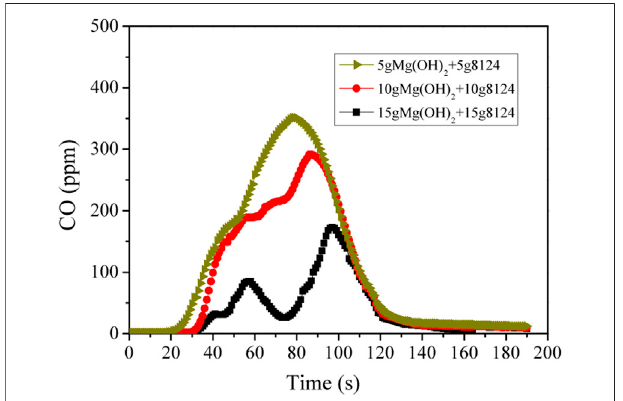
FIGURE 10 | CO concentration of compound foam with Mg(OH) 2 and 8124.